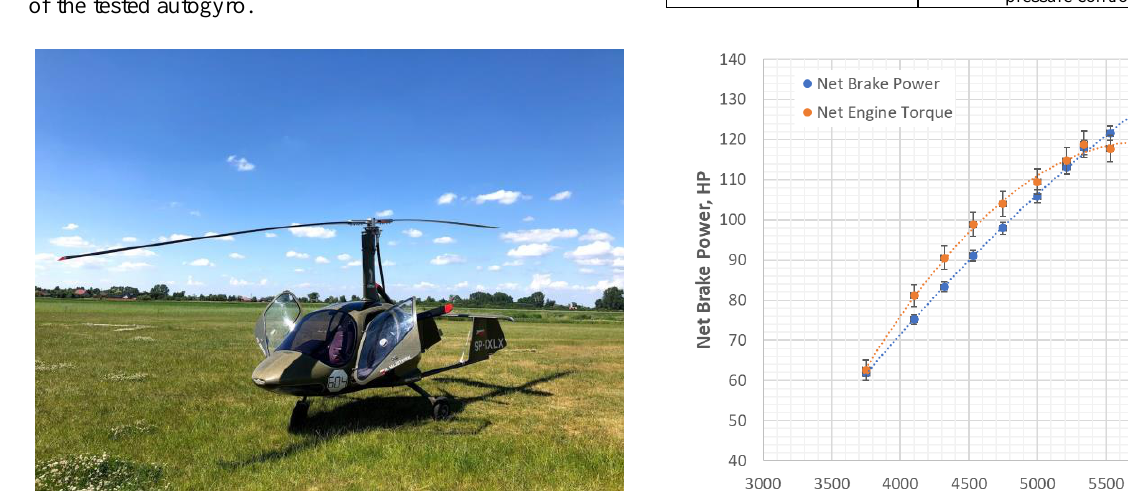
Fig. 1. Tercel autogyro produced by Aviation Artur Trendak